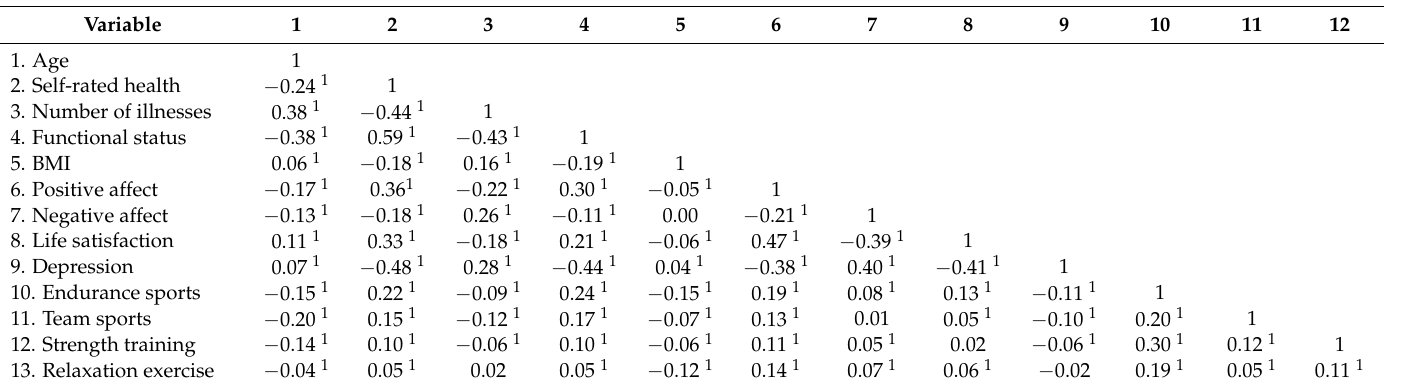
Table 2. Correlations between Age and Variables of